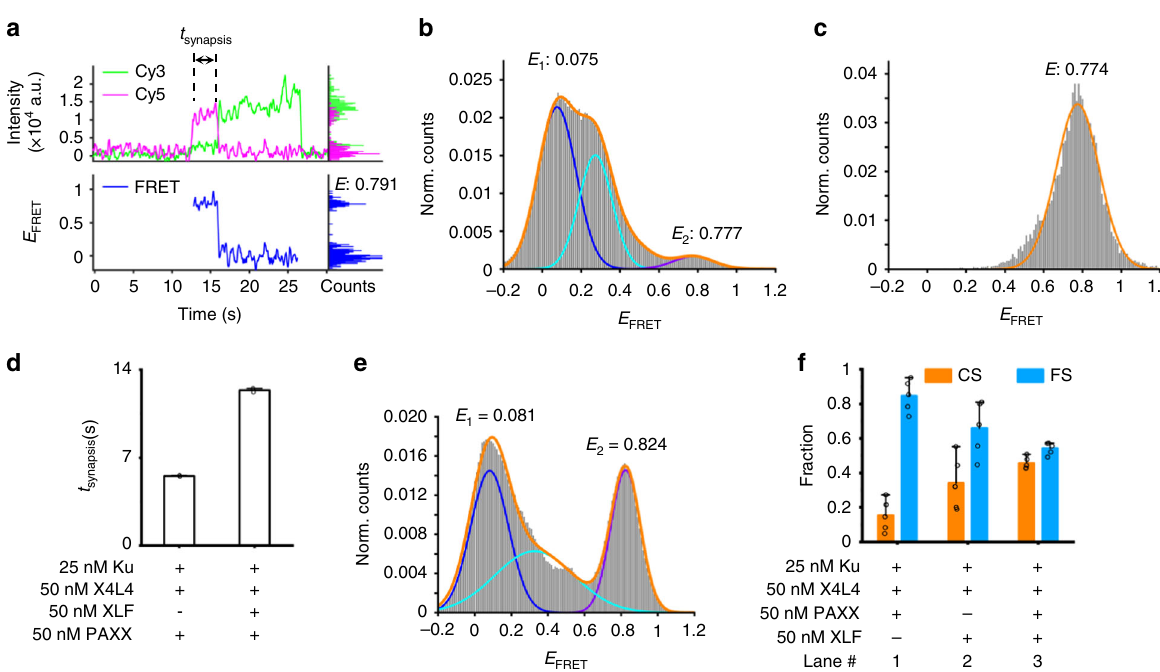
Fig. 4 PAXX increases end proximity of two dsDNA but with modest ef fi ciency. a Representative single-molecule time traces of donor (green) intensity, acceptor (magenta) intensity, and corresponding E FRET values (blue) for synapsis mediated by 25 nM Ku, 50 nM X4L4, and 50 nM PAXX. The right parts are histograms of donor intensity (green), acceptor intensity (magenta), and E values (blue) within the synapsis period. b Histogram of E FRET values of all synapsis events mediated by Ku, X4L4, and PAXX. The E value shown was obtained from a Gaussian fi t of the highest peak of each kind of synaptic complex ( FS and CS ). n = 223 molecules. c Histogram of E FRET values of all synapsis events with E FRET ≥ 0.6. The E value was obtained from a Gaussian fi t of the corresponding peak. n = 33 events. The data used here is the same batch as that used in b . d Dwell time of CS complex stimulated by PAXX alone or XLF plus PAXX. Only the high E FRET ( E ≥ 0.6) events with both start and end time points within the detection time window were included. Error bars represent SD of two replicates. The corresponding dwell distributions and exponential fi ts are shown in Supplementary Figs. 6e, f. e Histogram of E FRET values of all synapsis events mediated by Ku, X4L4, XLF, and PAXX. The E value shown was obtained from a Gaussian fi t of the highest peak of each type of synaptic complex ( FS and CS ). n = 429 molecules. f Fraction of low E FRET ( FS ) complex and high E FRET ( CS ) complex mediated by different combinations of NHEJ factors. Data are represented as the mean ± SD of at least three replicates. Source data are provided as a Source Data1 fi